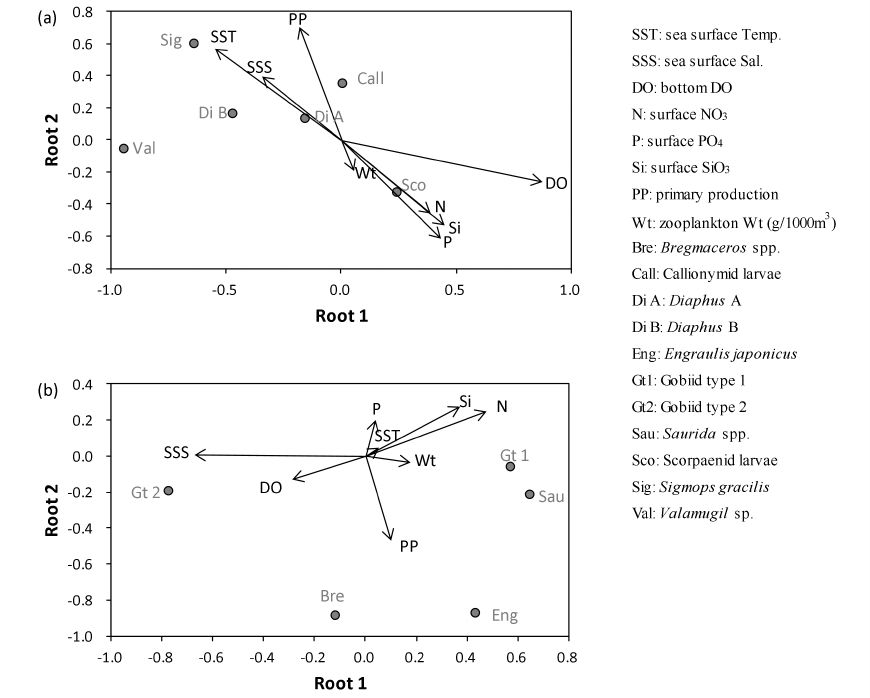
Fig. 7. Ordination diagram of canonical correlation analysis (CCA) showing the relationships between hydrographic factors and abundance of dominant larval fish taxa in the northeasterly monsoon season (a) and the southwesterly monsoon season (b) .